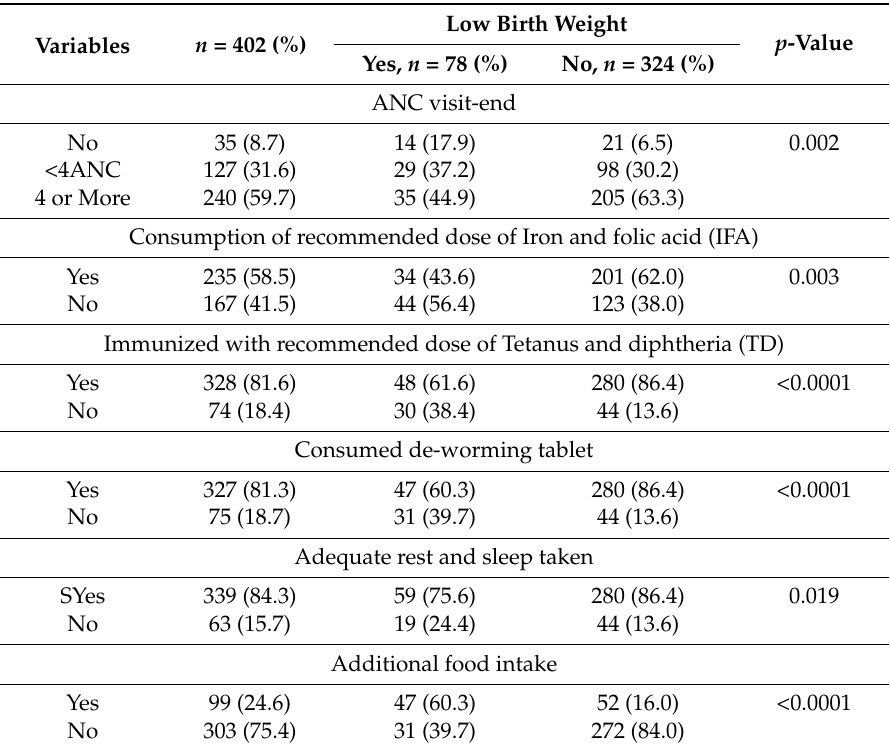
Table 2. Association between the utilization of selected antenatal care services and low birth weight (LBW) *. Variables n = 402